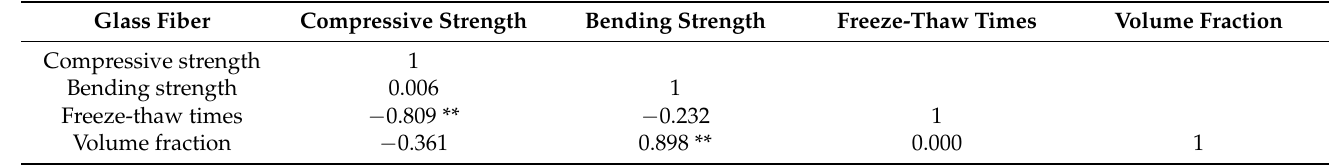
Table 10. Pearson correlation coefficient of glass fiber cement-based materials.